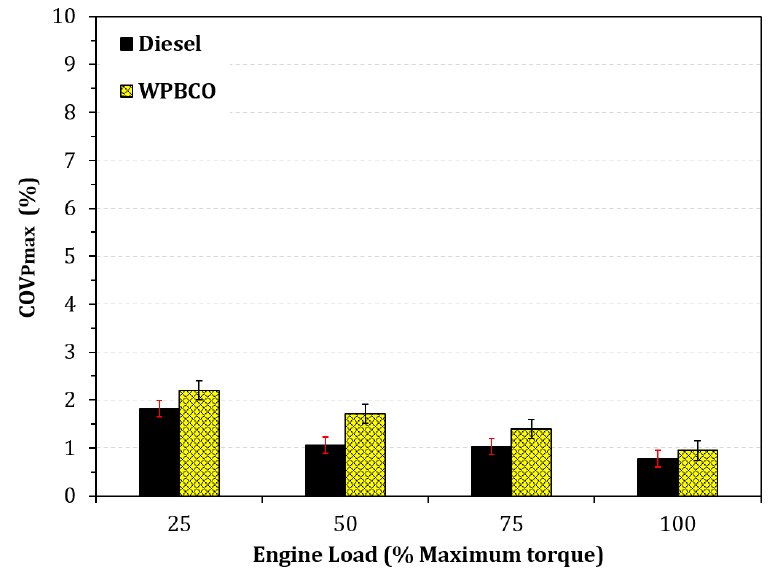
Figure 8. Variation of coefficient of variance in P max with respect to the engine load.